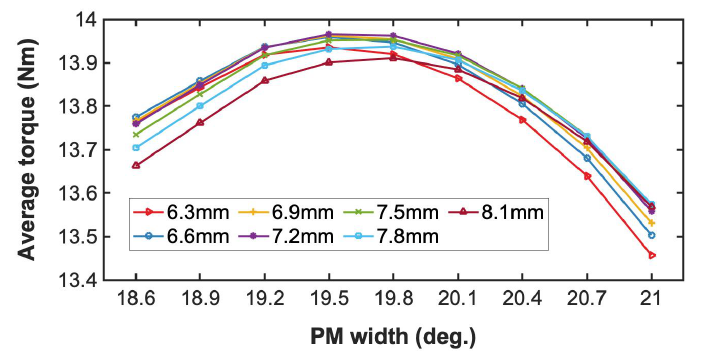
Figure 13. Relationship between tooth/PM width combination and average torque.